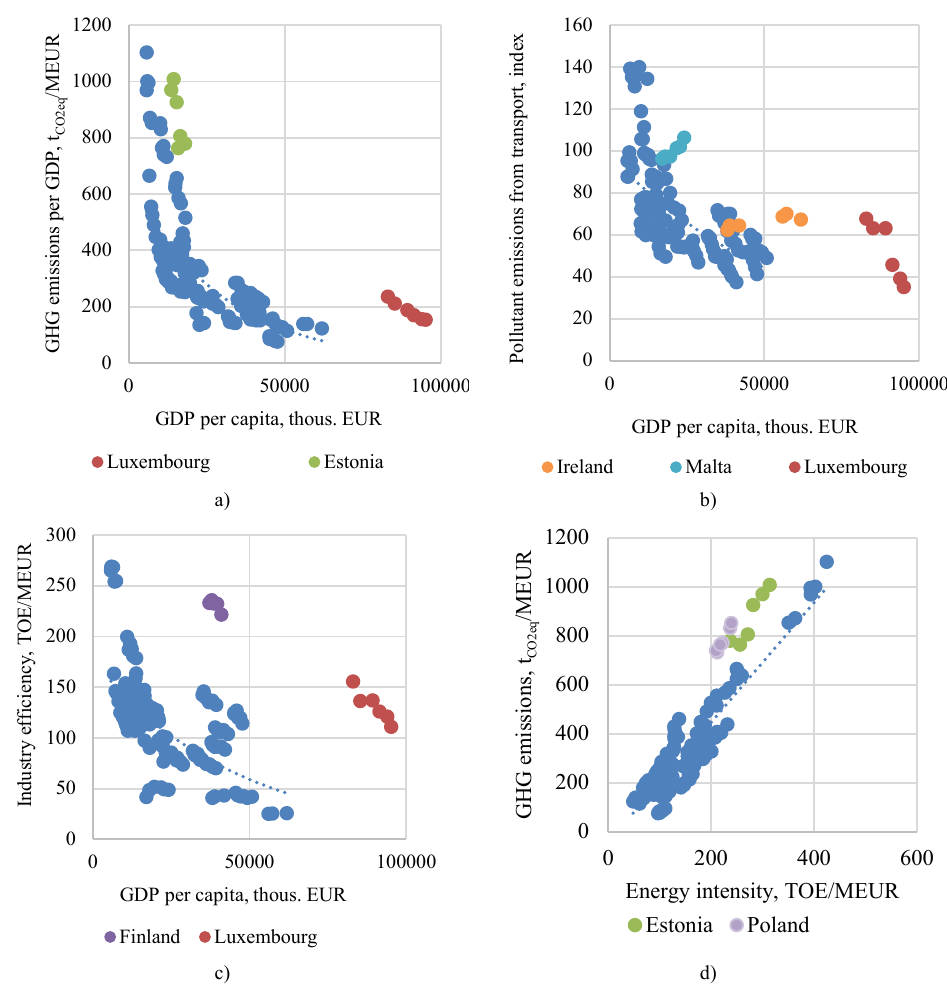
Fig. 6. Results of correlation analyses for indicator